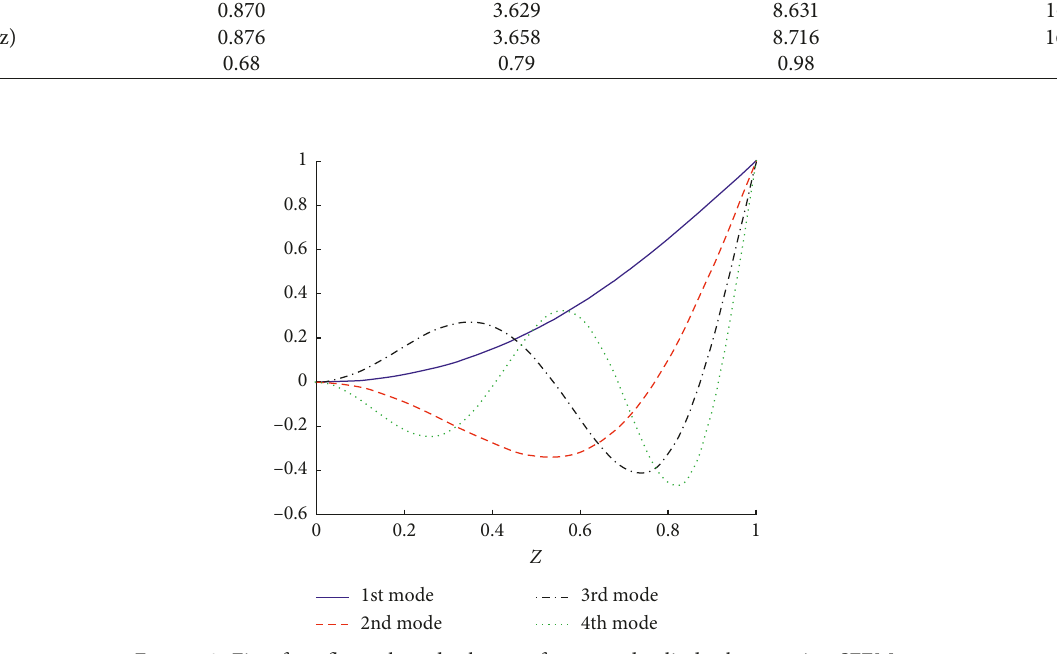
Figure 3: First four flexural mode shapes of a tapered cylinder beam using SFEM.